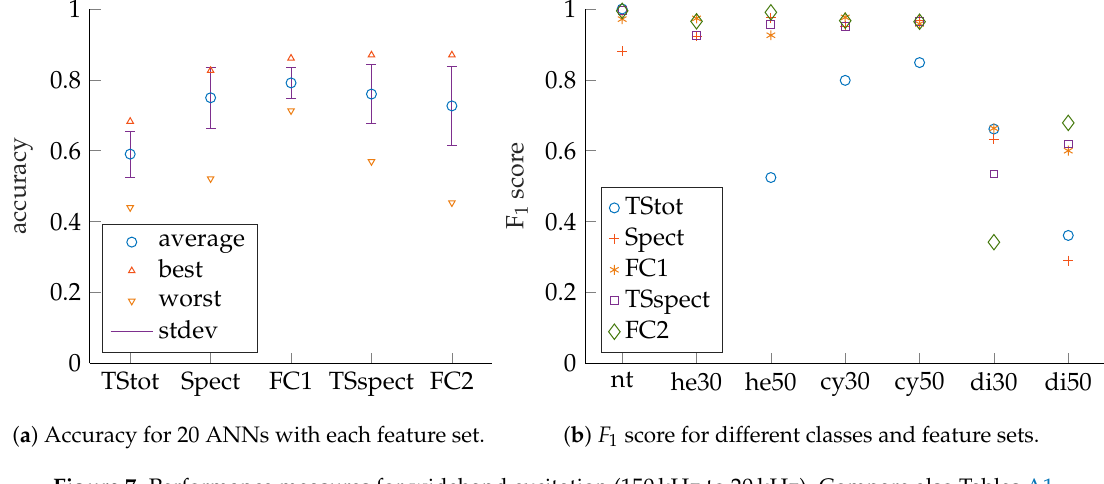
Figure 7. Performance measures for wideband excitation (150kHz to 20kHz). Compare also Tables A1 and A2 in the Appendix